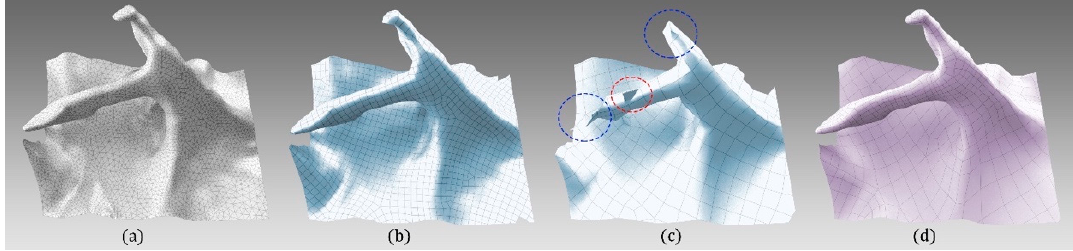
Figure 10. Porcupinefish: punctual retouches carried out with manual polygonal modelling techniques, on the tops of the spines: optimized triangular mesh ( a ); automatic quad-dominant remeshing: medium resolution ( b ); automatic quad- dominant remeshing: low resolution. Topological defects appear on the model: flipped normals and non-manifold faces ( c ); manual retopology: the result is a highly optimized meshes but it requires skilled users and long time ( d ).